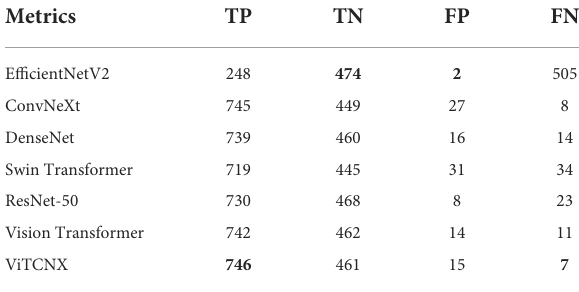
TABLE 3 Statistics of ViTCNX and other six models for binary classification.